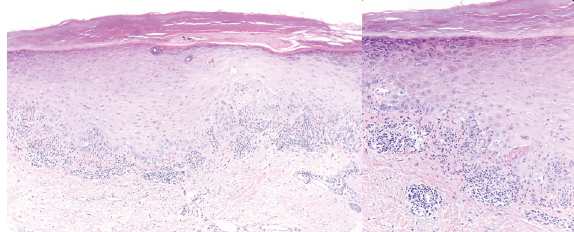
Figure 2: Skin biopsy shows a lichenoid lymphocytic infiltrate with acanthosis, hyperkeratosis, hypergranulosis, and civatte bodies (apoptotic basal